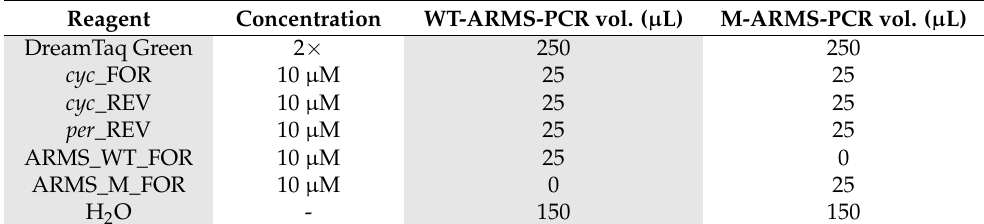
Table 4. Setup of two PCR master mixes for ARMS-PCR screening.